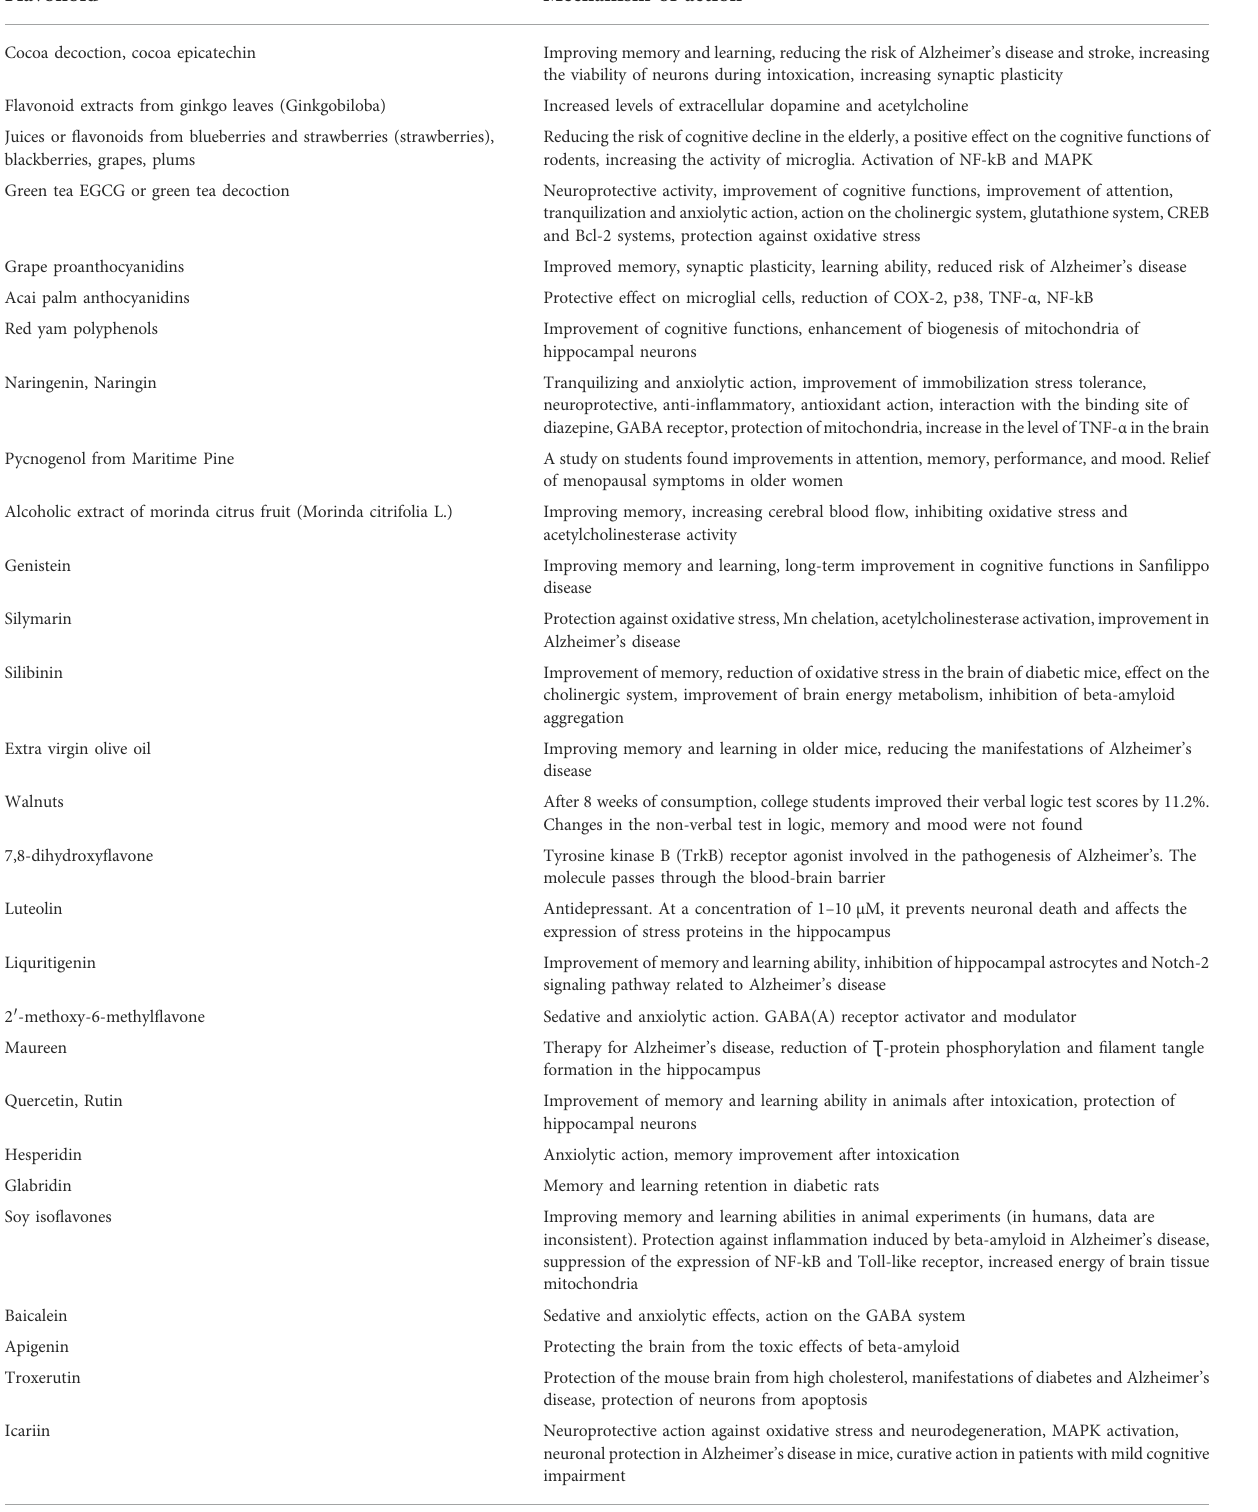
TABLE 1 In fl uence of oral intake of fl avonoids and fl avonoid-containing plant products on intracellular signaling systems of the brain and cognitive functions.